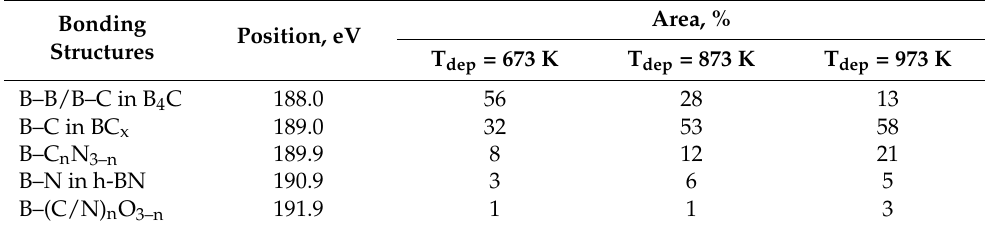
Table 3. Fine structure of B1s spectra of the LPCVD BC x N y films deposited at different temperatures.